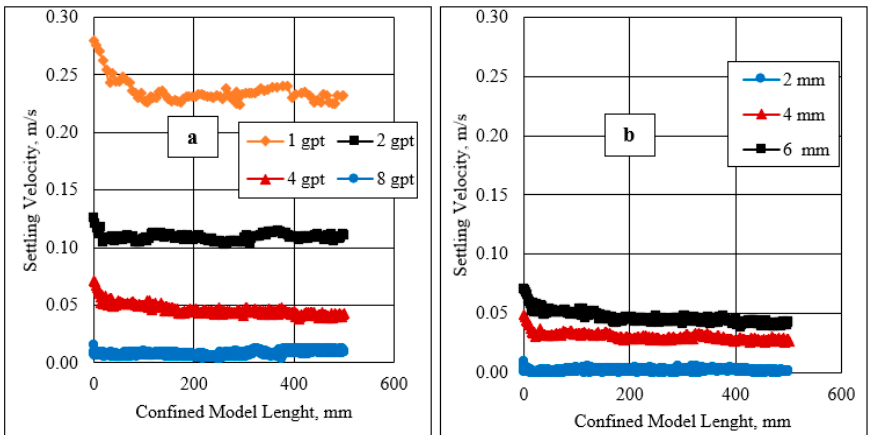
Figure 12. Terminal spherical particle settling in the confined model using ( a ) 6 mm particle size, and ( b ) 4 gpt HVFR concentration.